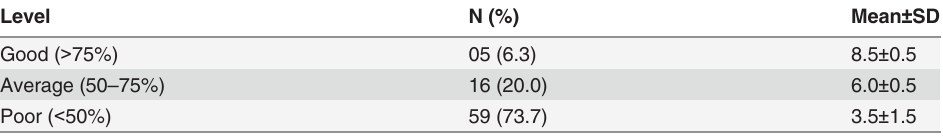
Table 3. Level of Knowledge and mean score of Nurses on PEP for HIV, Tubah, 2013 Level N